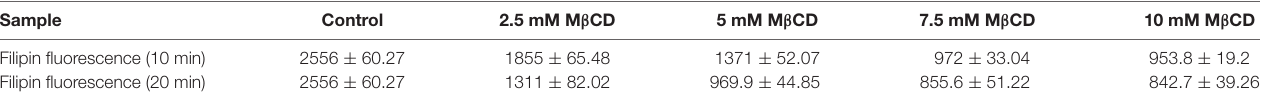
TABLE 4 | Alteration in fluorescence of Filipin III, labeling unesterified membrane cholesterol, upon transient sequestering of cholesterol for varying durations.